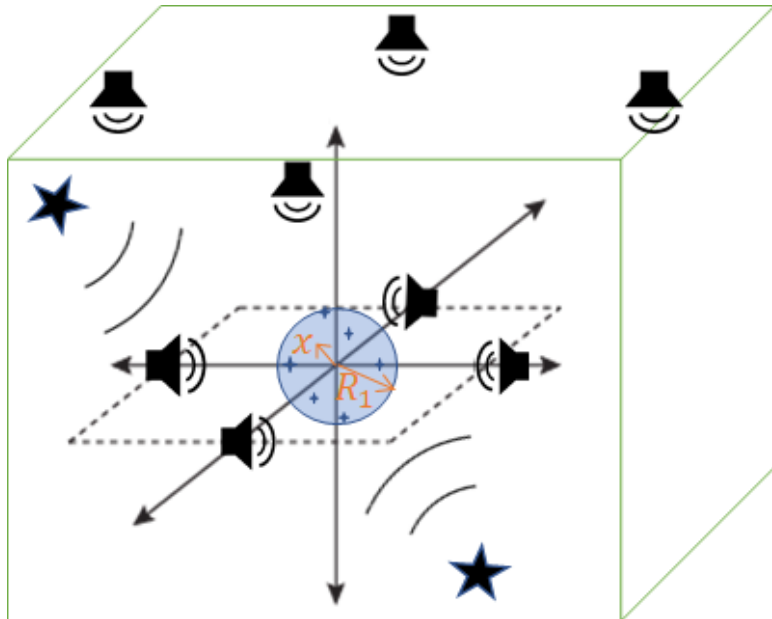
Figure 1. ANC system in a 3-D room. Black stars represent primary sources, loudspeakers represent secondary sources, the blue sphere represents the control region, and dark blue stars represent error microphones over the control